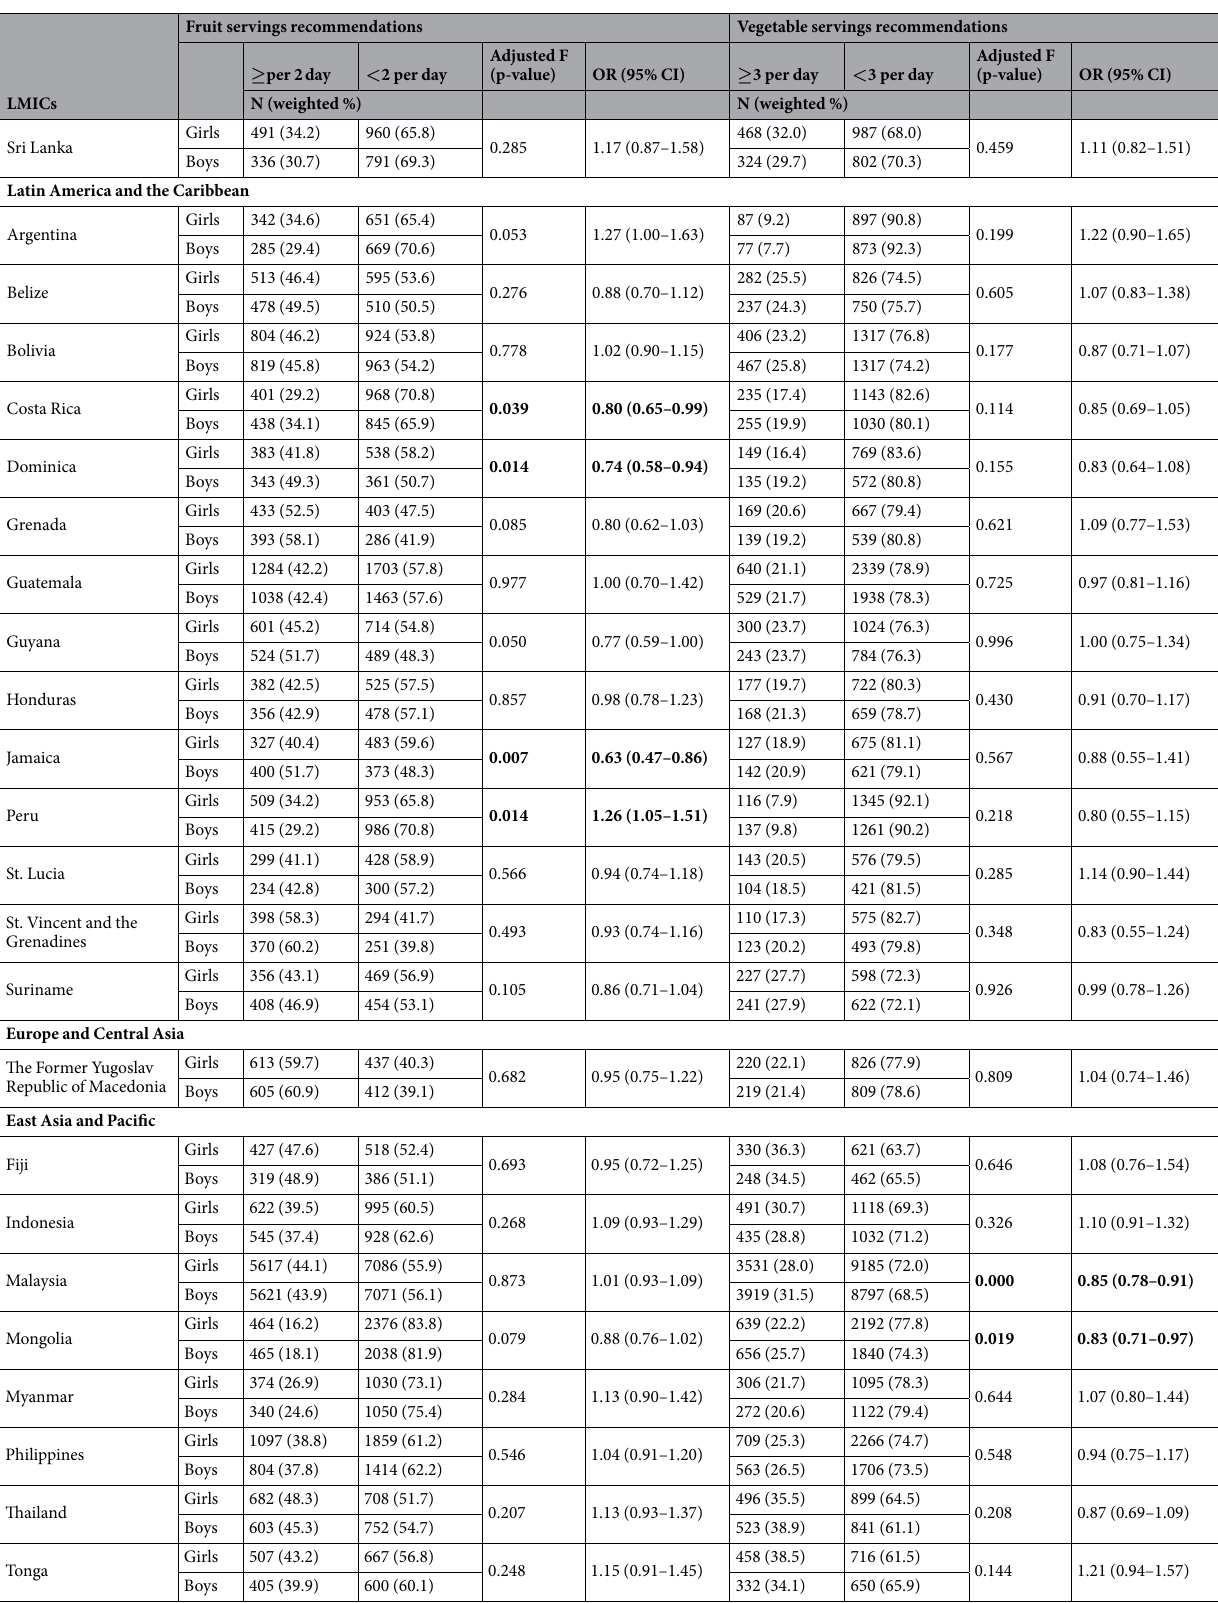
Table 1. Differences in the daily recommended intake of fruits and vegetables among adolescent girls and boys in Low-and Middle-Income Countries from the Global School-based Student Health Survey (2004–2013) (N = 163,123 adolescents from 49 LMICs). OR = Odds Ratio; CI = Confidence Interval; Boldface value are significant at P < 0.05; - no data